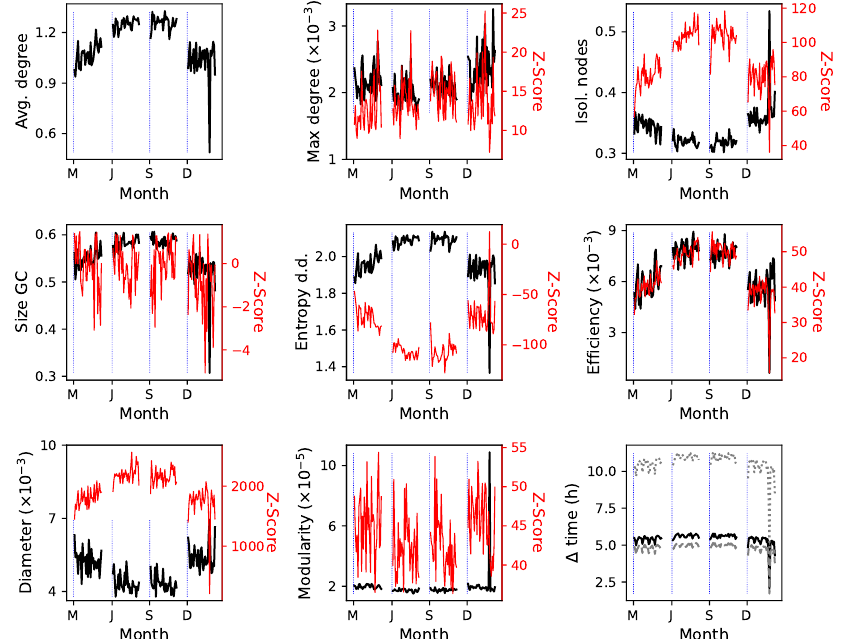
Figure A9. Properties of the interaction networks for executed trajectories in 2018. Each panel depicts the evolution through time of a topological metric, as defined in Section 2; black (left Y axes) and red lines (right Y axes), respectively, correspond to the raw values and their Z-Scores. The vertical blue dotted lines represent the beginning of each month. In the last panel, the black line corresponds to the median, the gray dashed one to the mean, and the gray dotted one to the maximum. M: March; J: June; S: September; and D: December.